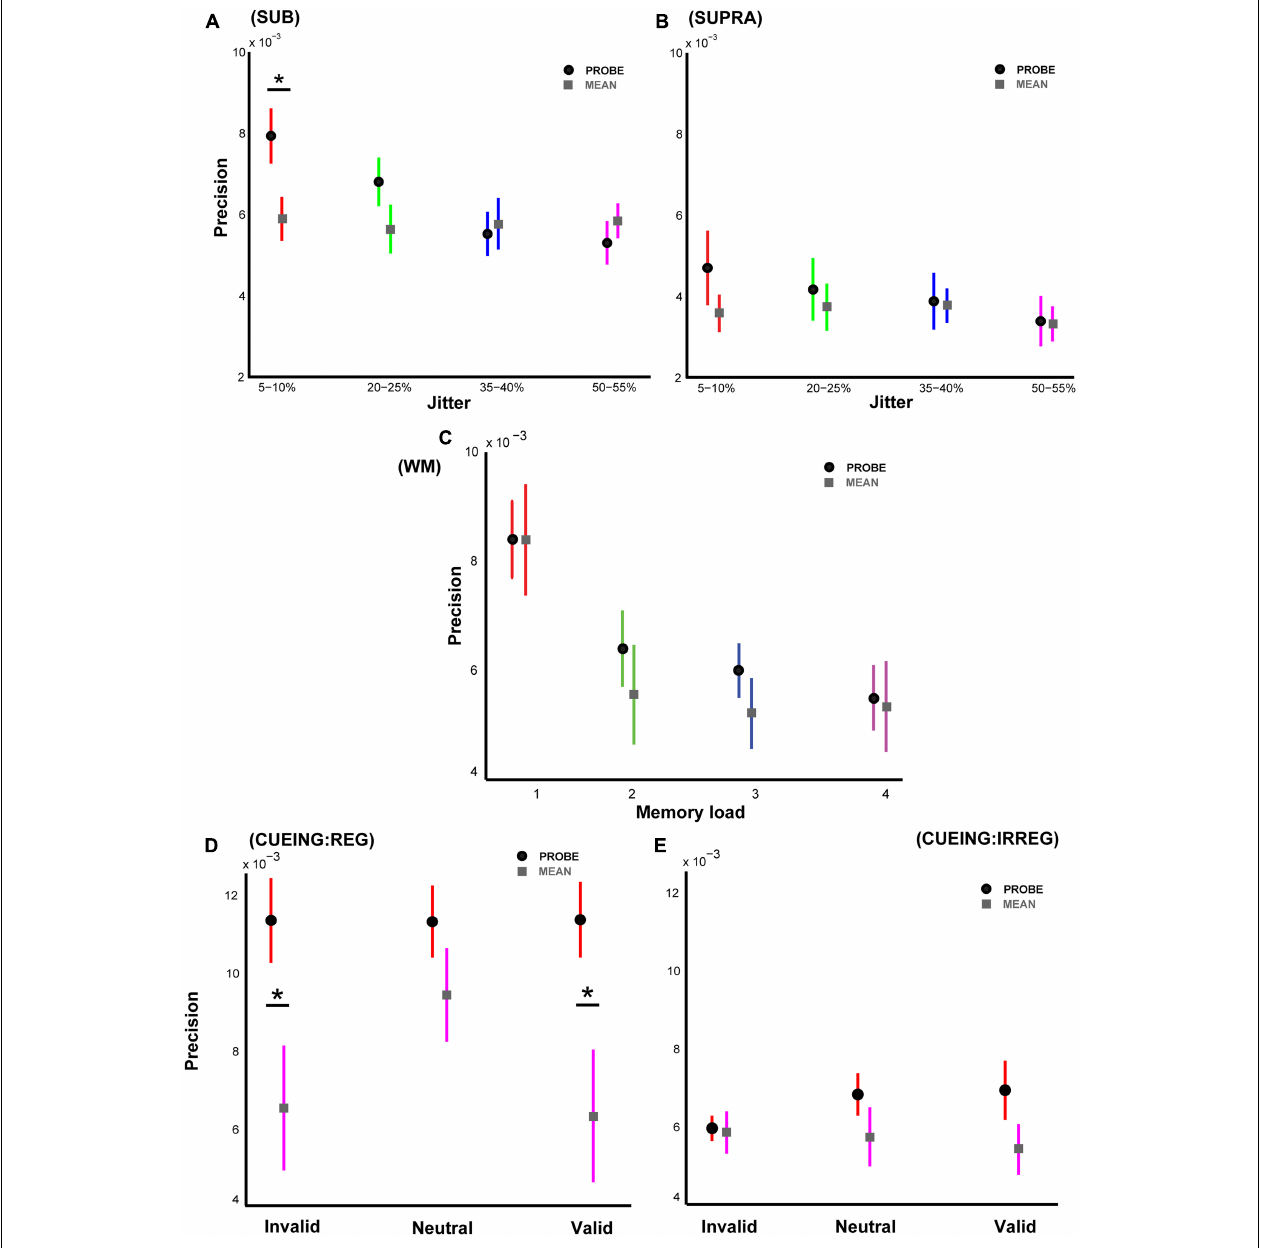
FIGURE 2 | Experimental results based on responses to average interval duration. Precision based on a hypothetical response to the average duration of the intervals in a sequence with mean precision in gray squares is plotted alongside the actual precision values with mean precision in black circles as in